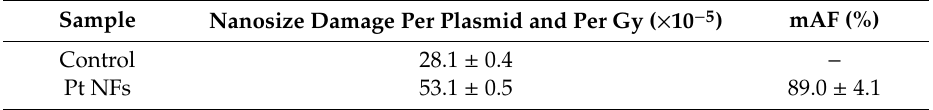
Table 2. Yields of controls and plasmids loaded with Pt NFs under γ -ray irradiation. The molecular Amplification Factor (mAF) is also